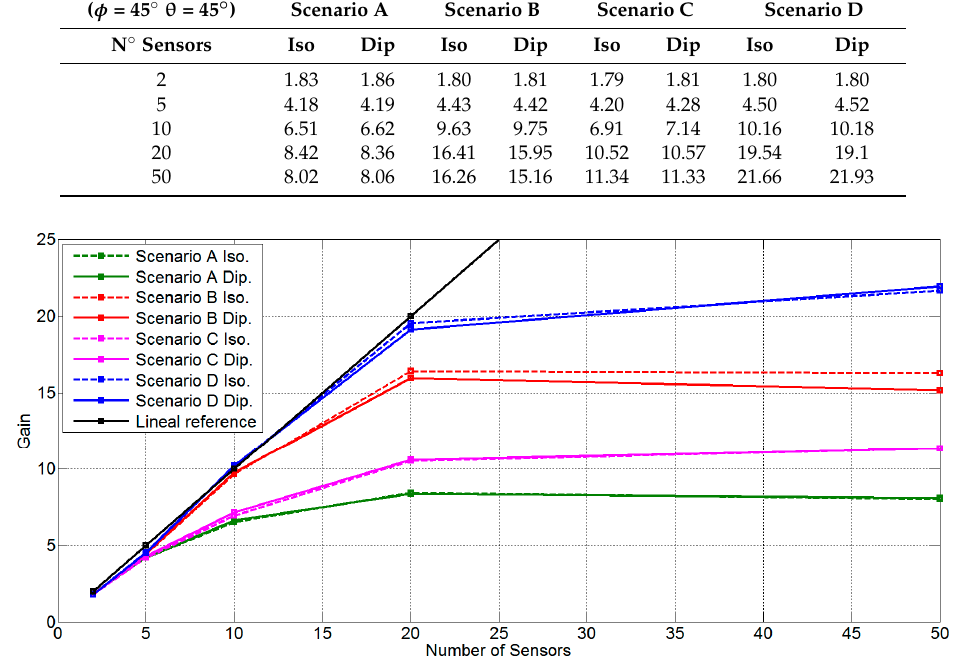
Figure 8. Results for search angle = 0°, θ = 45°, all scenarios and both antennas.